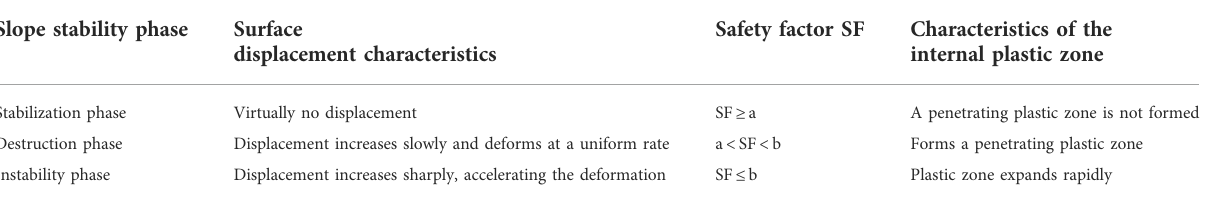
TABLE 1 Stability of the relational model based on the displacement characteristics of the slope